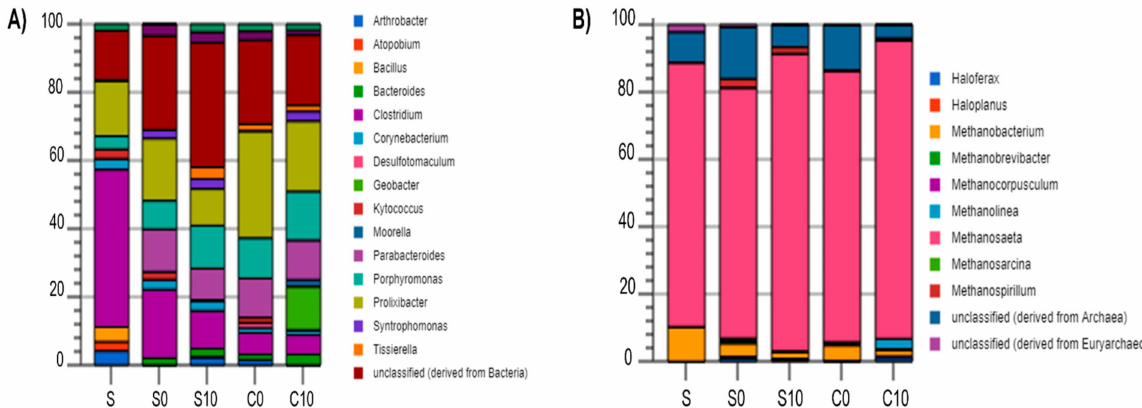
Figure 3. Bacteria ( A ) and Archaea community structure ( B ) at genus level. Genus level with relative abundance lower than 1% were included in unclassified groups. Sludge from control reactor (S), sludge from reactor with granular activated carbon (GAC) (S0), sludge from reactor with GAC biofilm developed before undertaking the BMP test (S10), GAC biofilm from reactor with GAC (C0) and GAC biofilm from reactor with GAC biofilm developed before undertaking the BMP test